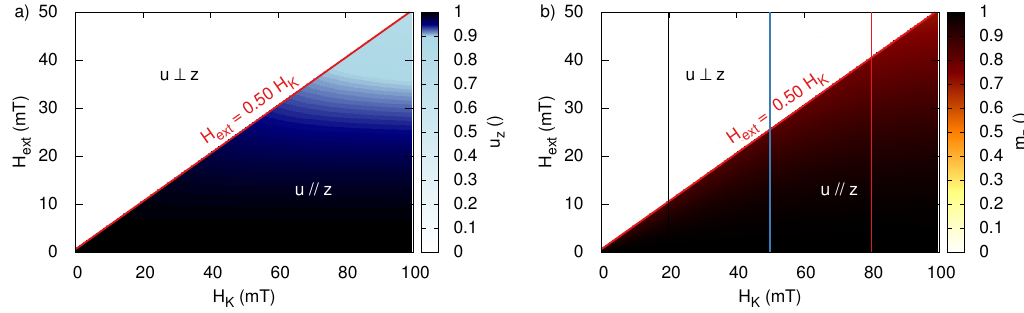
Figure 5. ( a ) The z-component of the anisotropy, averaged over one period, in dynamical equilibrium during the application of the rotating field as function of the particle coercivity H K and the amplitude of H ext . ( b ) The z-component of the magnetization (i.e., the particles’ response) at the end of the time-varying field